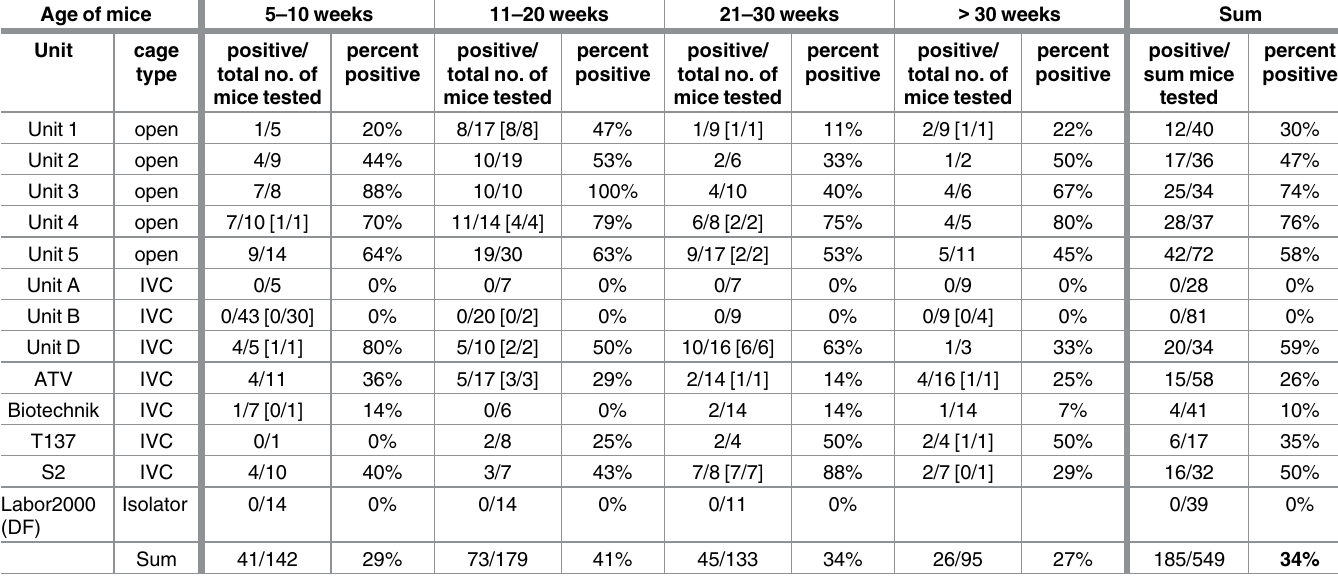
Table 3. Prevalence of MuAstV RNA in mice at the DKFZ versus age of mice and housing unit. Age of